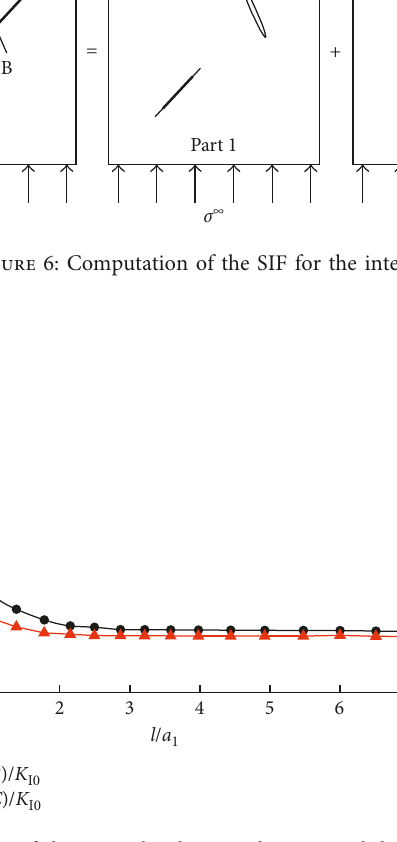
Figure 7: Relation of the normalized SIF and wing crack length a ° , θ ( a 1 70 . 5 ° ). 2 , β (cid:31) 45 (cid:31) (cid:31)